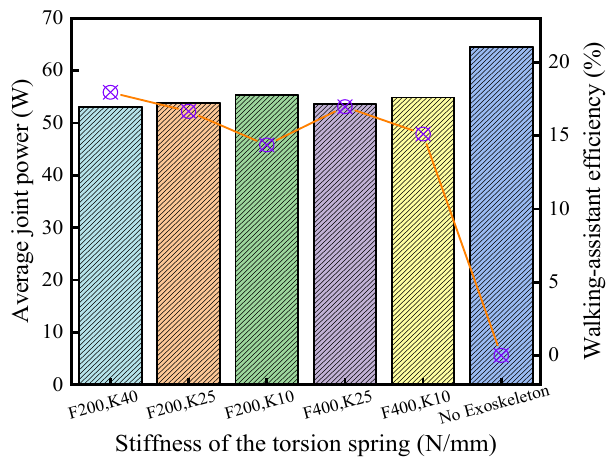
Figure 11. Walking-assistance efficiencies of the Figure 11. Walking ‐ assistance efficiencies of the HESM.